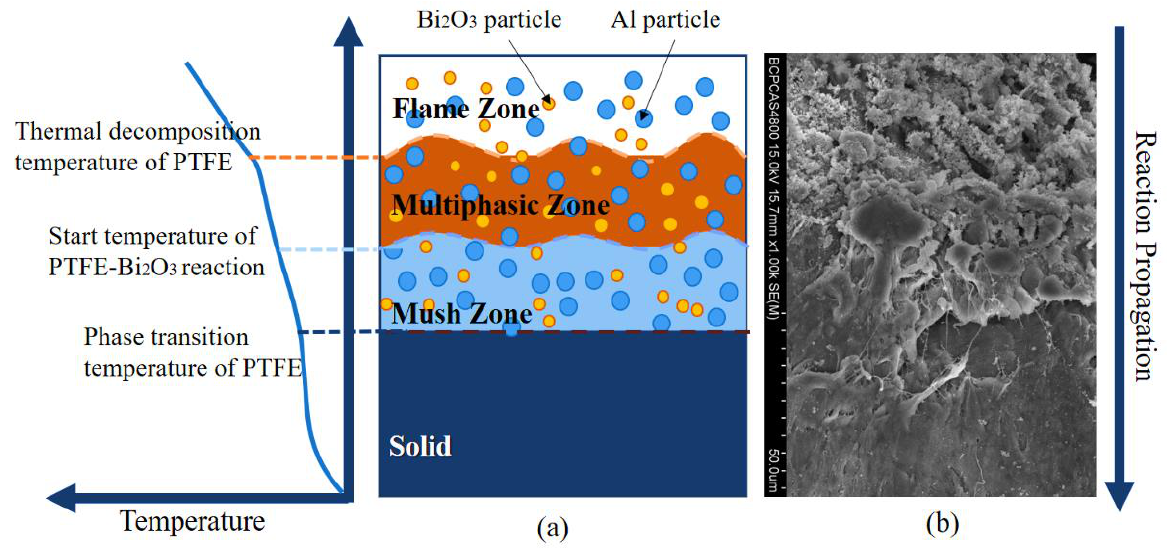
Figure 16. ( a ) Reaction propagation of PAB; ( b ) SEM of PAB reaction propagation.